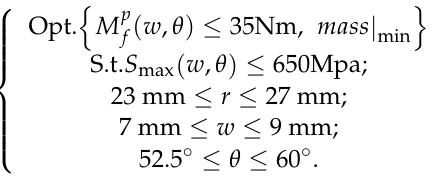
peak for FLHD booms with S max